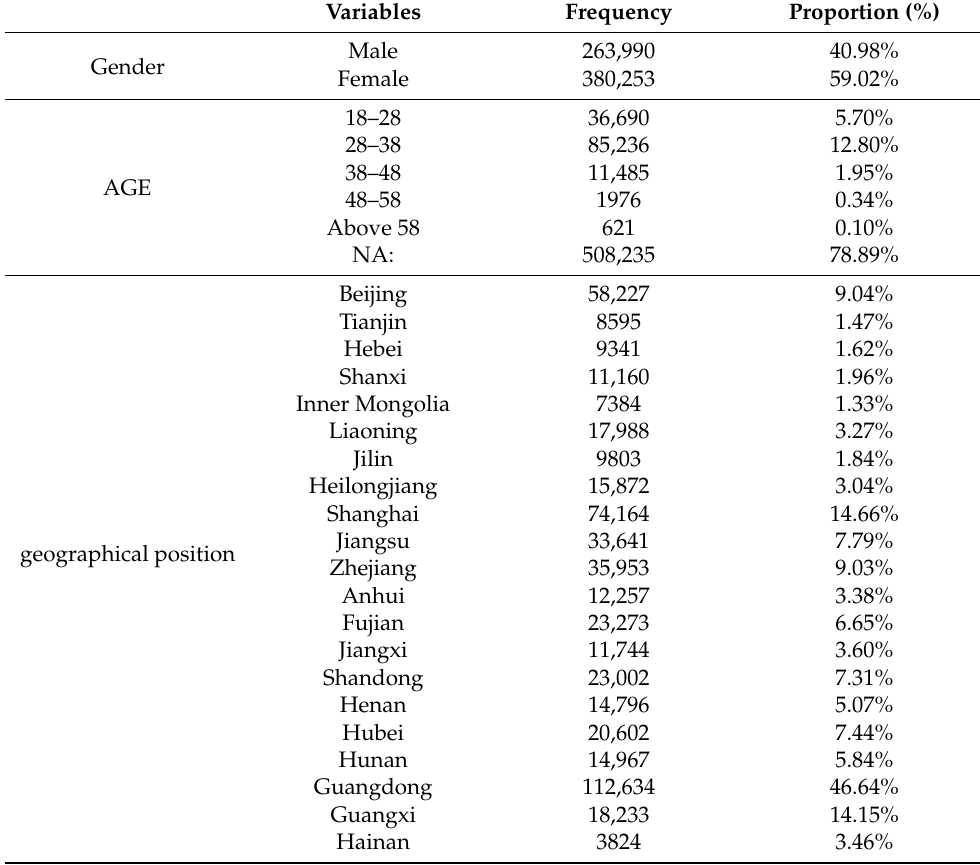
Table 1. Demographics of active microblog